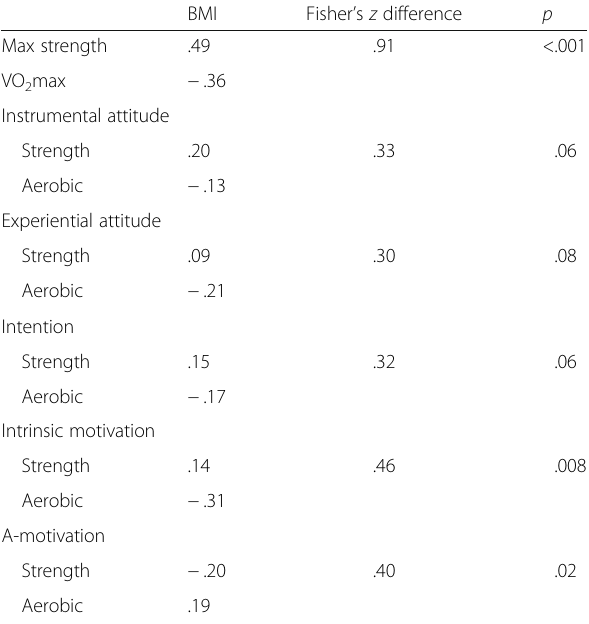
Table 5 Comparison of correlations between BMI and aerobic variables and between BMI and strength